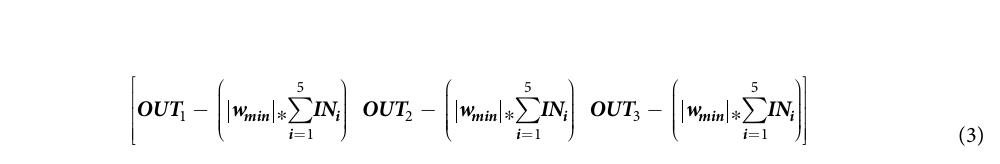
Table 2. Output Layer (ON) (Fig. 8c) Error Matrix showing the Absolute Deviation of the Physical Programmed Conductance Values and the Ideal Mapped Neural Network Values per